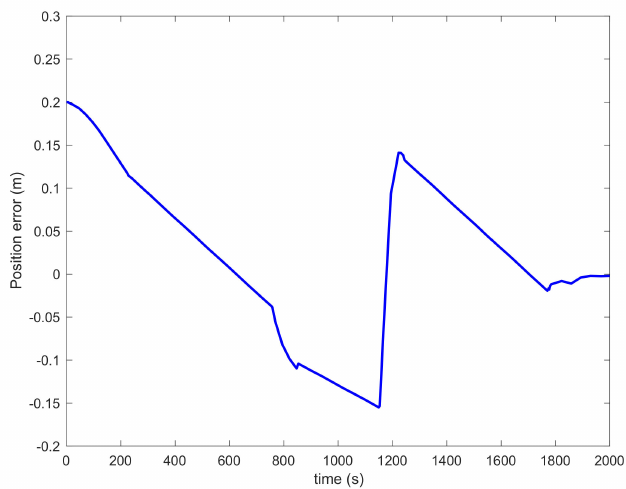
Figure 6. Position error of